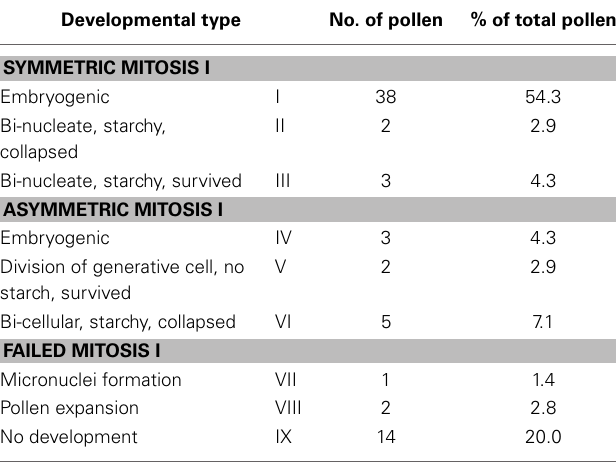
Table 1 | Types of pollen development as observed in live-cell imaging experiments during the initial 2 weeks of culture under conditions supportive for pollen